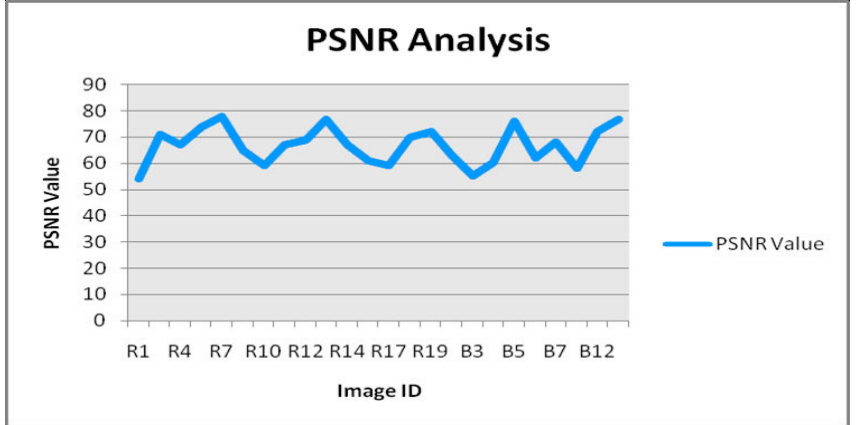
Figure 10. PNSR value